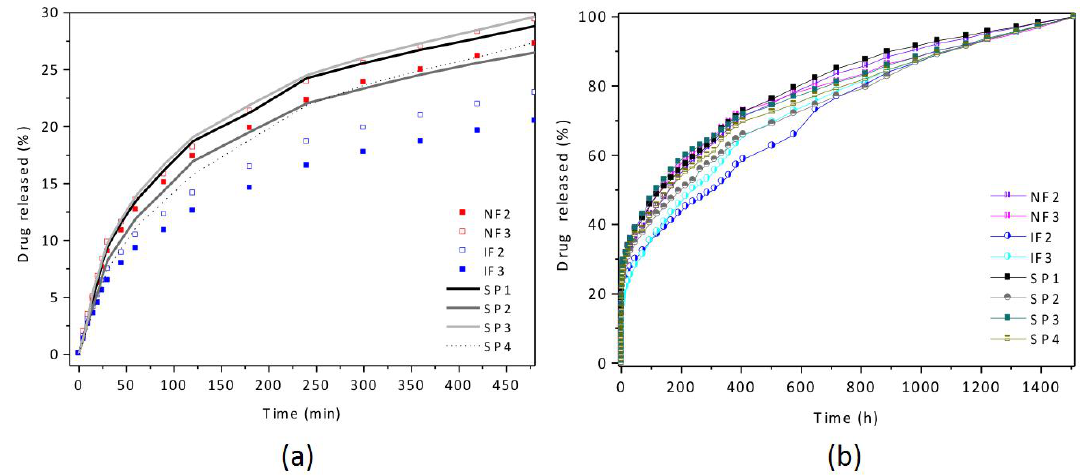
Figure 7. Cumulative drug release of different pore structures: ( a ) short-term and ( b ) long-term. The drug release profile of all the pore geometries can be described by distinguishing two phases: (i) a short-term release with a higher release rate within the first 8 h, and (ii) a slow and